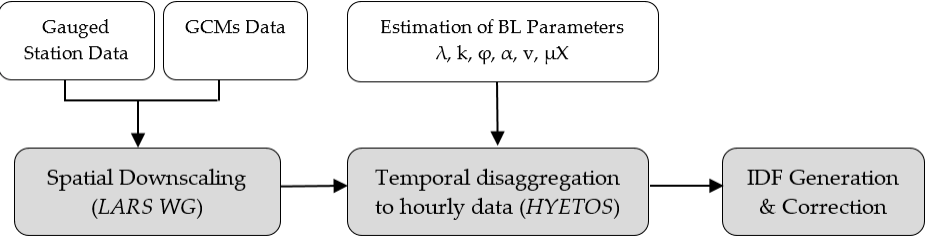
Figure 2. Methodological framework for the spatial downscaling-temporal disaggregation method (DDM) approach.